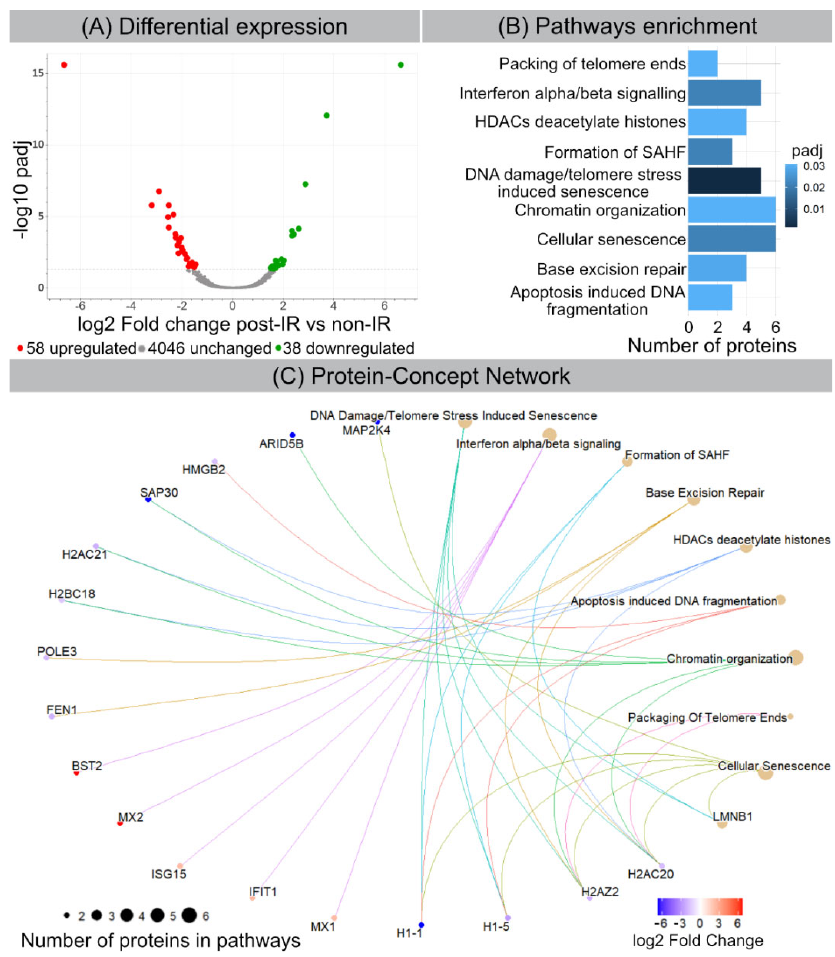
Figure 2. Radiation ‐ induced changes in protein expression . ( A ) Volcano plot showing differential protein expression following IR. ( B ) Senescence ‐ related pathway enrichment results were generated using ReactomePA R package. ( C ) Visualization of enriched pathways components by enrichplot R package.